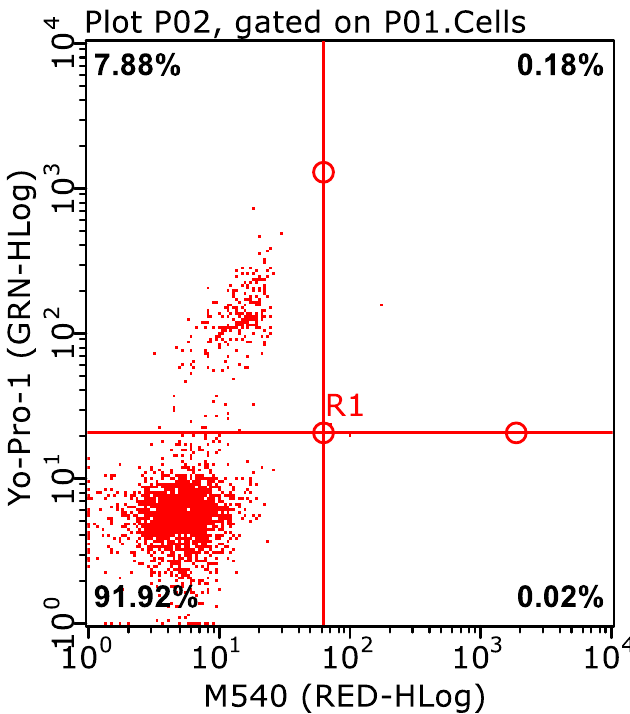
Figure 6. An example of a dot plot with live spermatozoa without destabilized membranes in the Experimental group in the lower left quadrant (91.82%): Mer-/Yo-Pro-1- (Merocyanine 540 (M-540) assessing capacitation-related membrane destabilization; YO-PRO-1 assay for apoptosis evalua- tion).